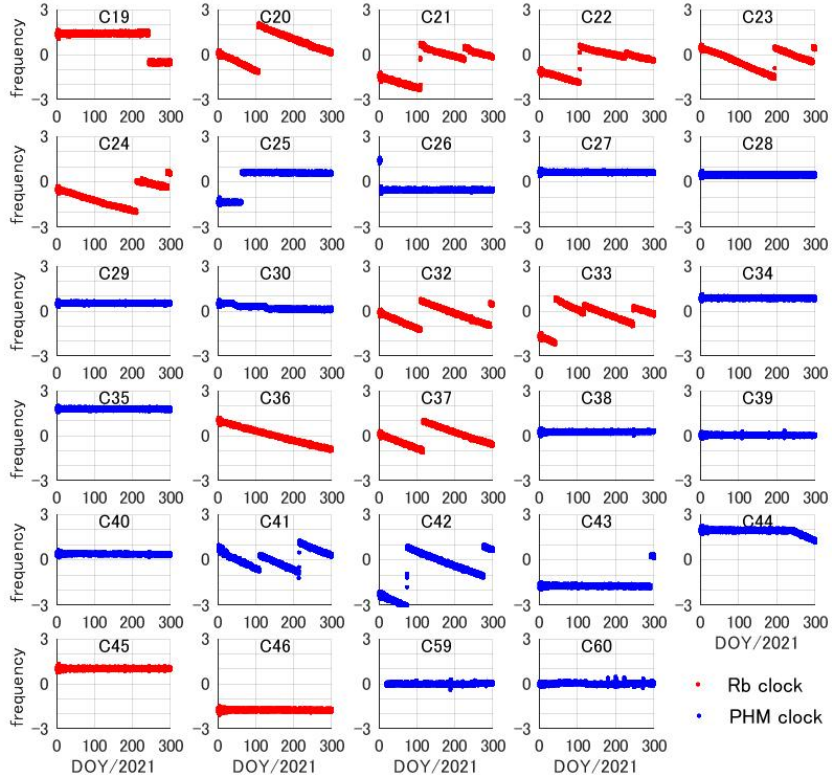
Figure 4. Frequency series of the BDS-3 onboard clocks from DOY 1 to 300, 2021 (units: 10 (cid:2879)(cid:2869)(cid:2869) s/s).